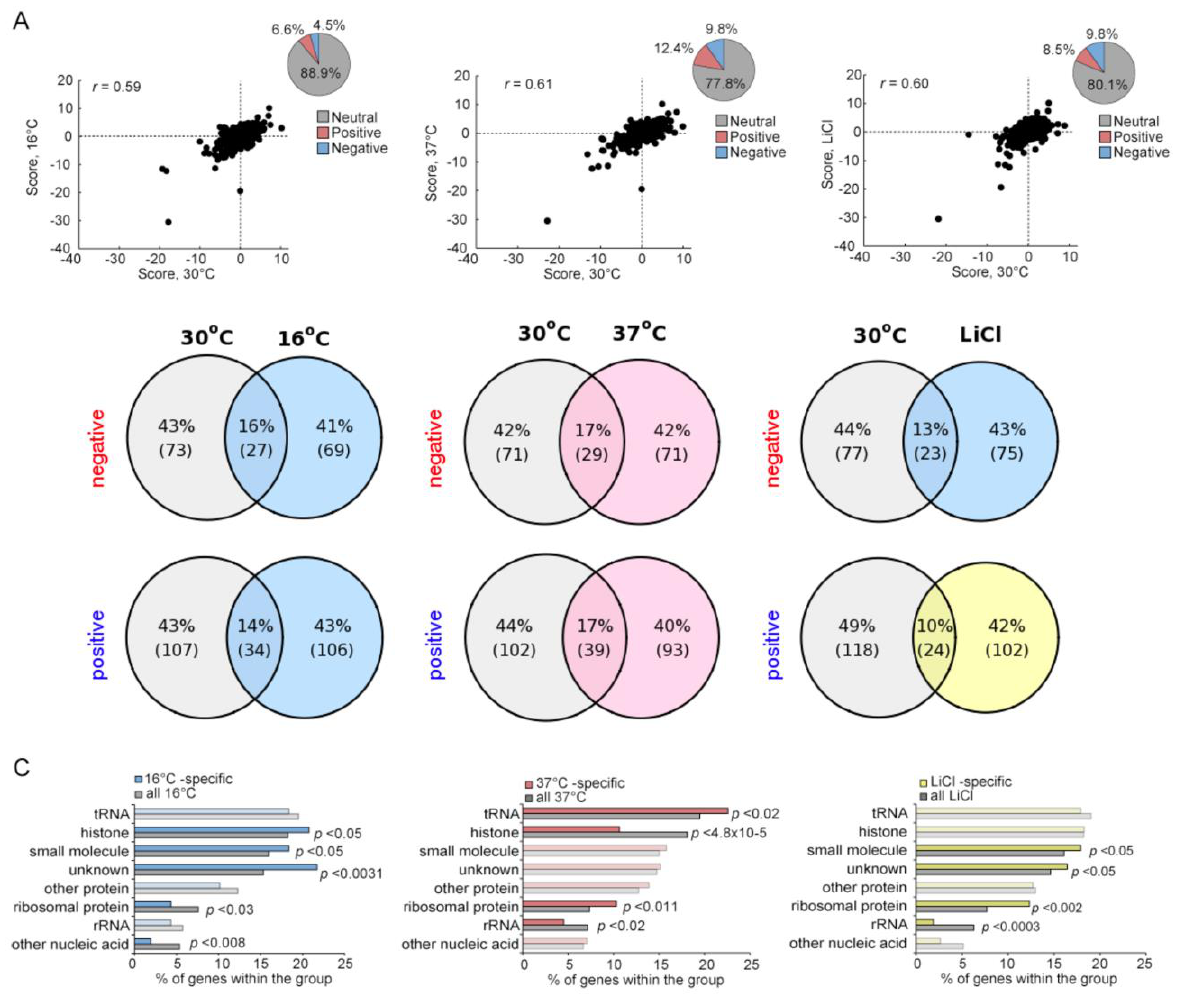
FIGURE 5: Plasticity of the methyltransferome in response to stress. (A) Genetic interactions for MT gene pairs under stress conditions (16°C, 37°C or LiCl) plotted against the those at 30°C. Insets: percentage of each interaction type. (B) Overlap of significant genetic inter- actions (|score| >2.5) between 30°C and the indicated stress conditions (C) Enrichment for genetic interactions between gene pairs by substrate type for stress